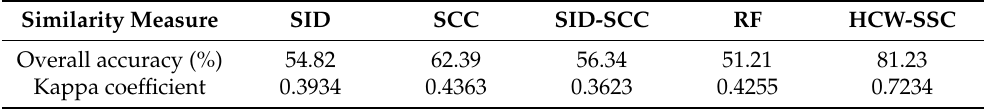
Table 6. Overall accuracy and kappa coefficient of each similarity measure based on Hyperion HSI (spectral information divergence (SID), spectral correlation coefficient (SCC), spectral information divergence–spectral correlation coefficient (SID-SCC), random forest (RF), and a new hybrid changing-weight classification method with a filter feature selection (HCW-SSC)).